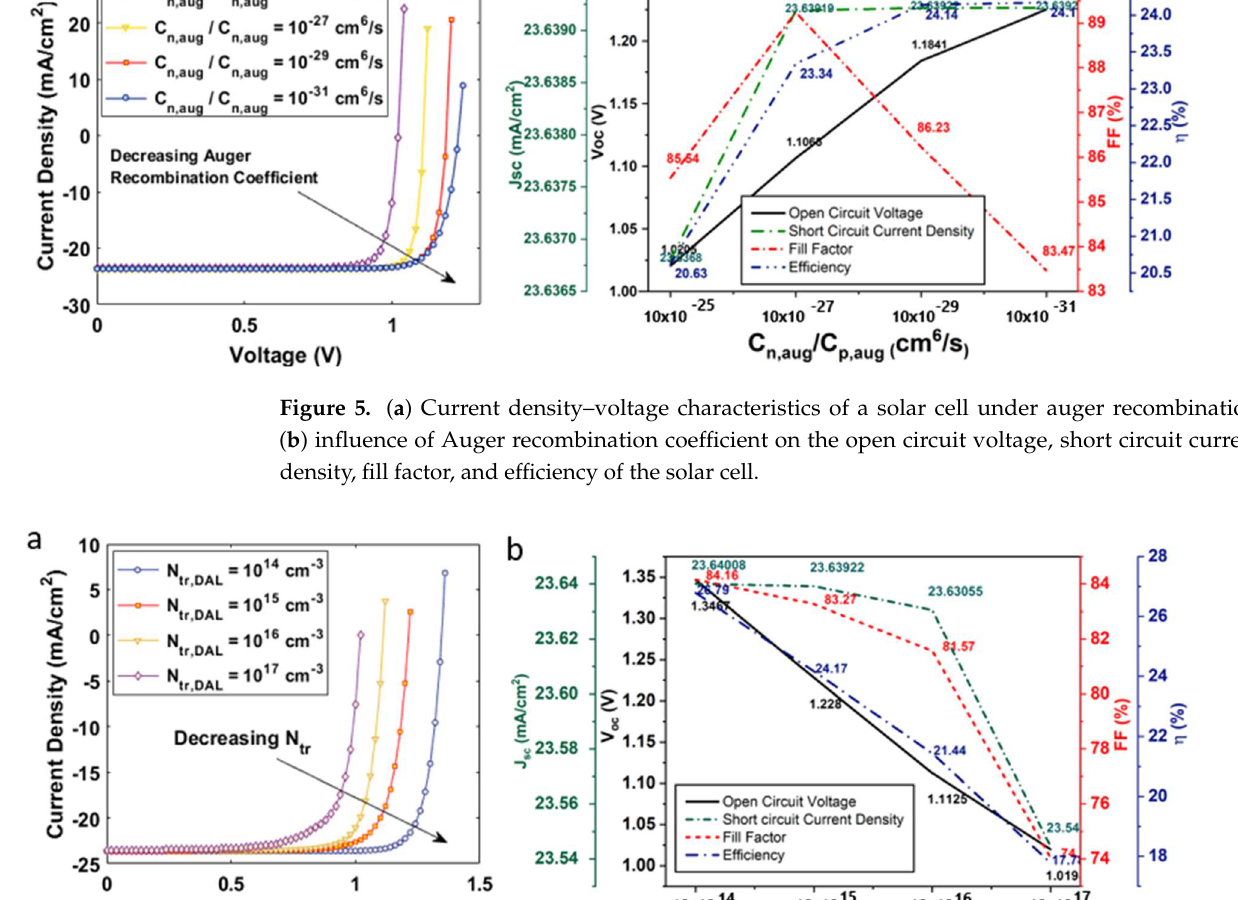
Figure 4. ( a ) Current density–voltage characteristics of a solar cell under radiative recombination; ( b ) influence of radiative recombination on the open circuit voltage, short circuit current density, fill factor, and efficiency of the solar cell.